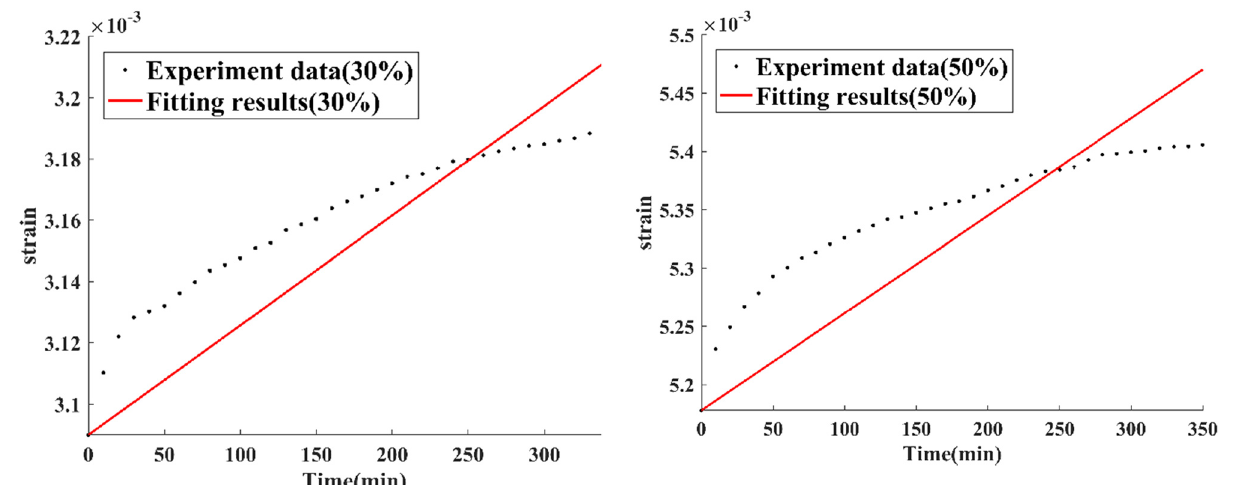
Figure 8: Fitting results based on the conventional Maxwell model and 30% stress level.